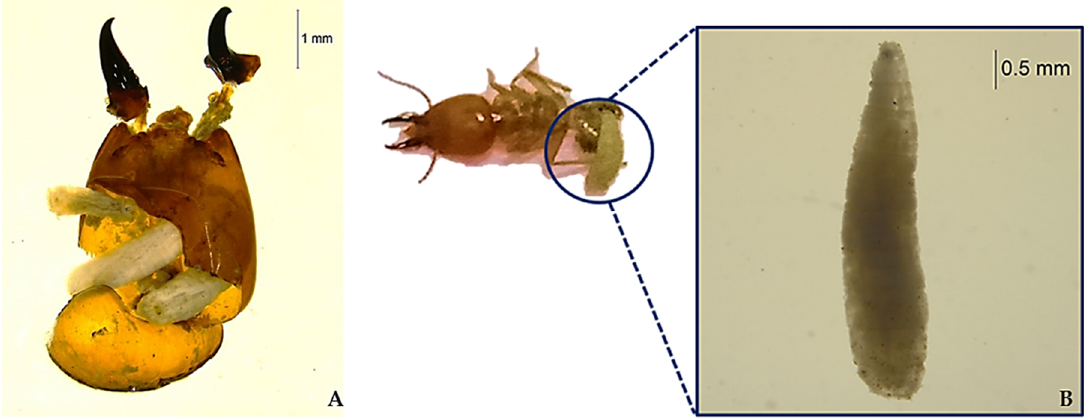
Figure 1. Larvae in the soldier termite head (A) and emerging from the soldier termite body (B).